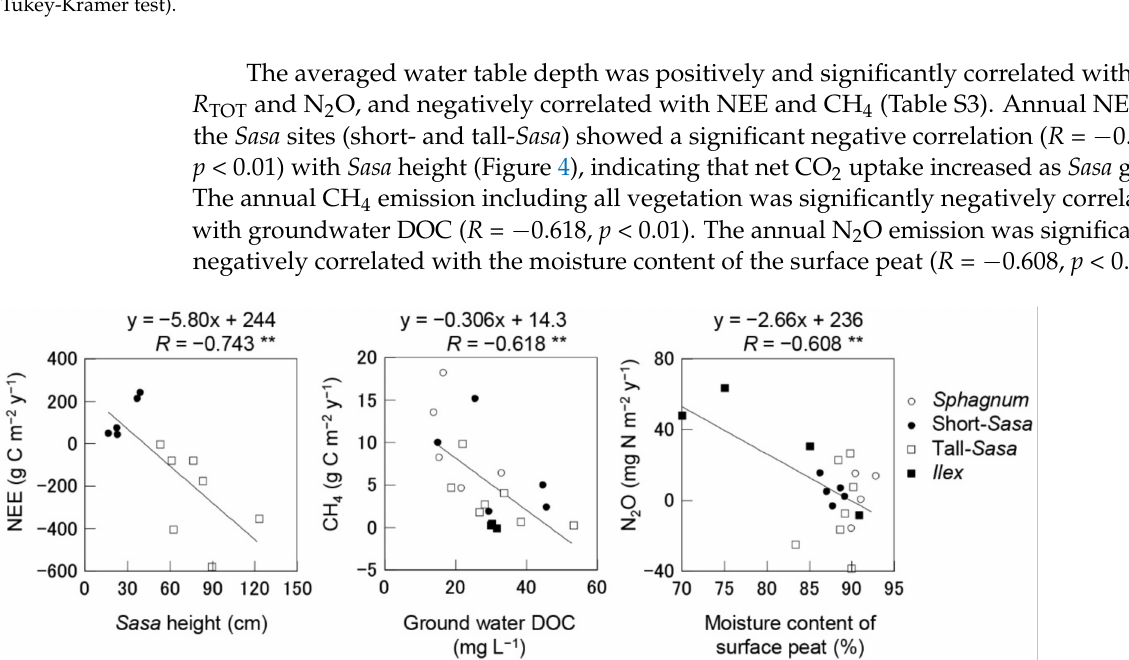
Figure 4. Relationships between environmental factors and annual GHG budgets. ** indicates significant at p <